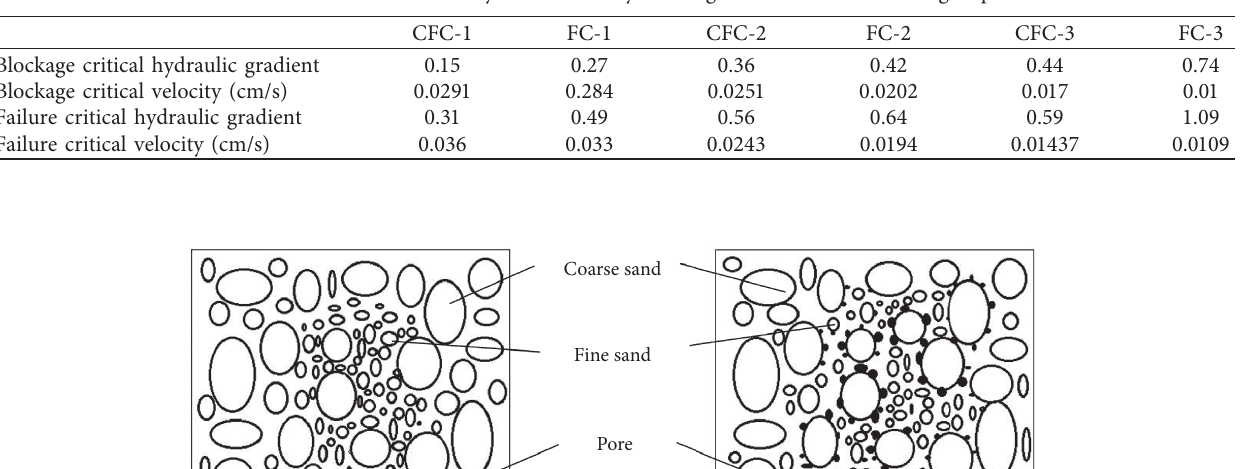
Table 3: Critical flow velocity and critical hydraulic gradient of CFC and FC groups.